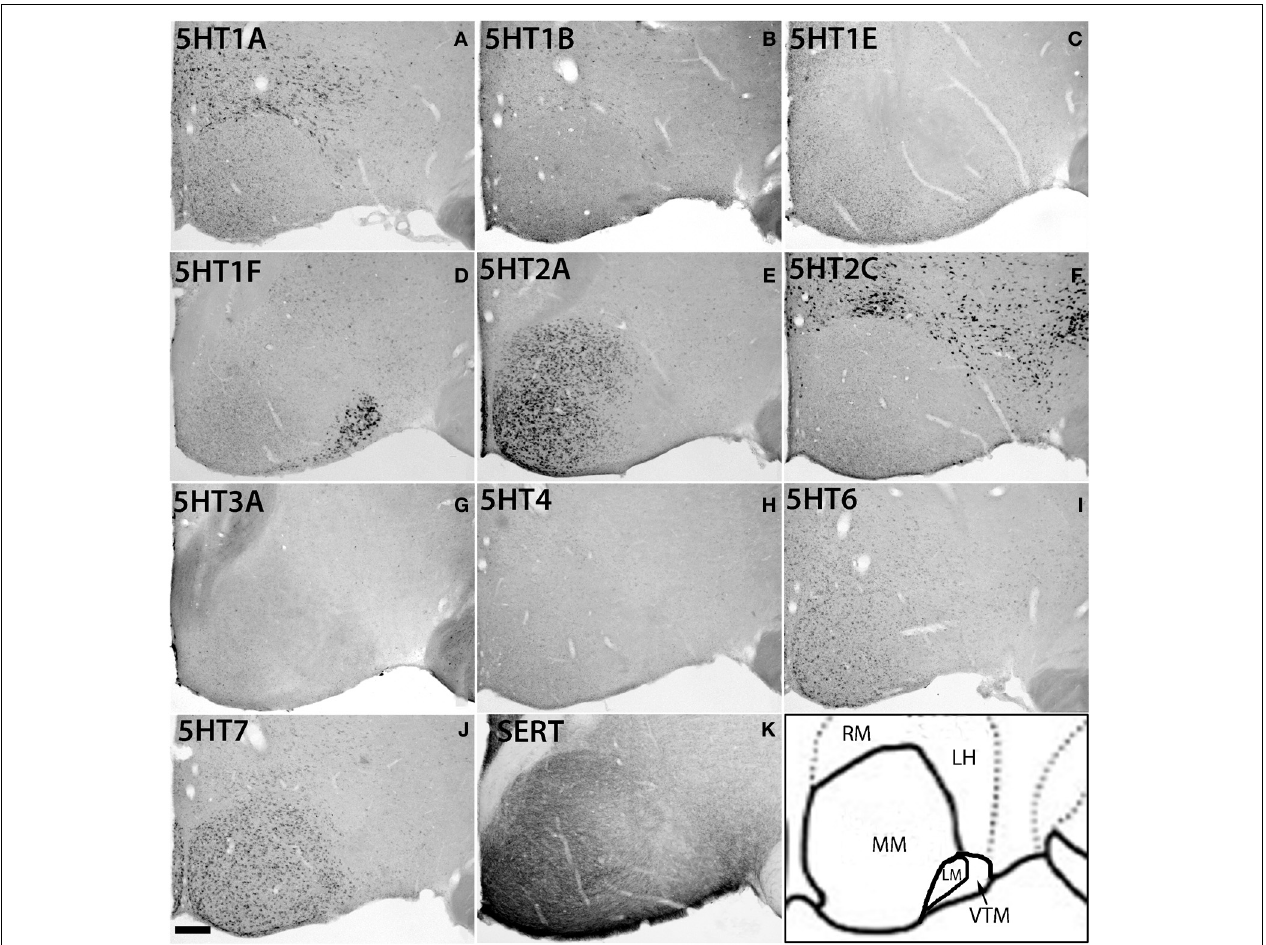
FIGURE 8 | ISH expression profiles of 5HTR s in hypothalamus. 5HTR mRNA expressions (A – J) and immunohistochemical staining with anti-SERT antibody (K) in lateral (ML), medial (MM), and ventral tuberomammillary (VTM) nuclei of hypothalamus. We observed the striking complementary relationship between the 5HT2A (E) and 5HT2C (F)